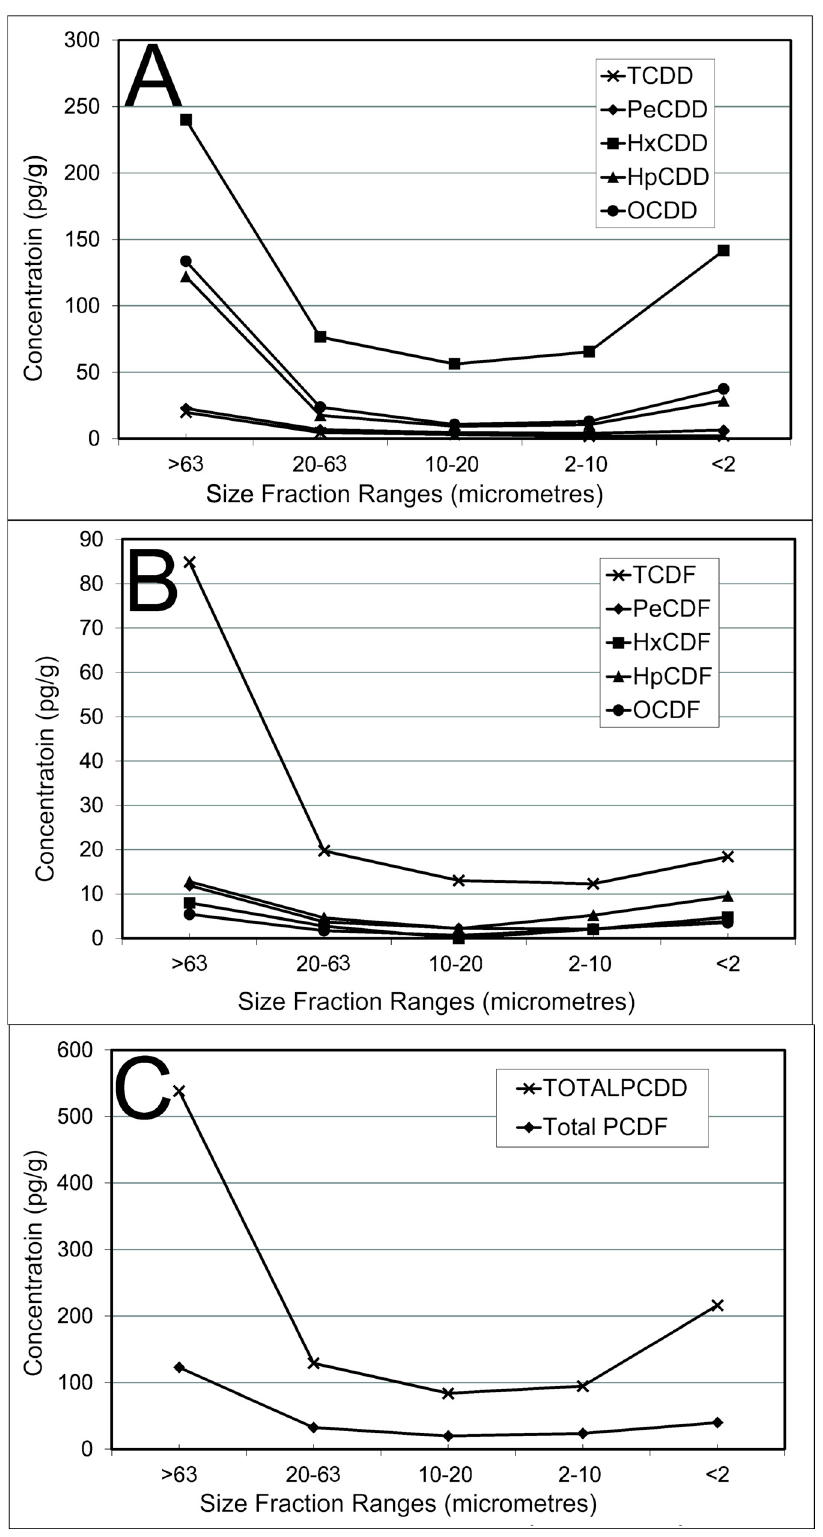
Figure 14. Plot showing the changes in concentration of dioxins ( A ), furans ( B ) and total homologues ( C ) between different size fractions at the 20–22cm depth interval. Peak concentrations occur in the coarsest fraction. Dioxin concentration increases in the finest two size fractions, whilst furan concentration remains relatively constant throughout.